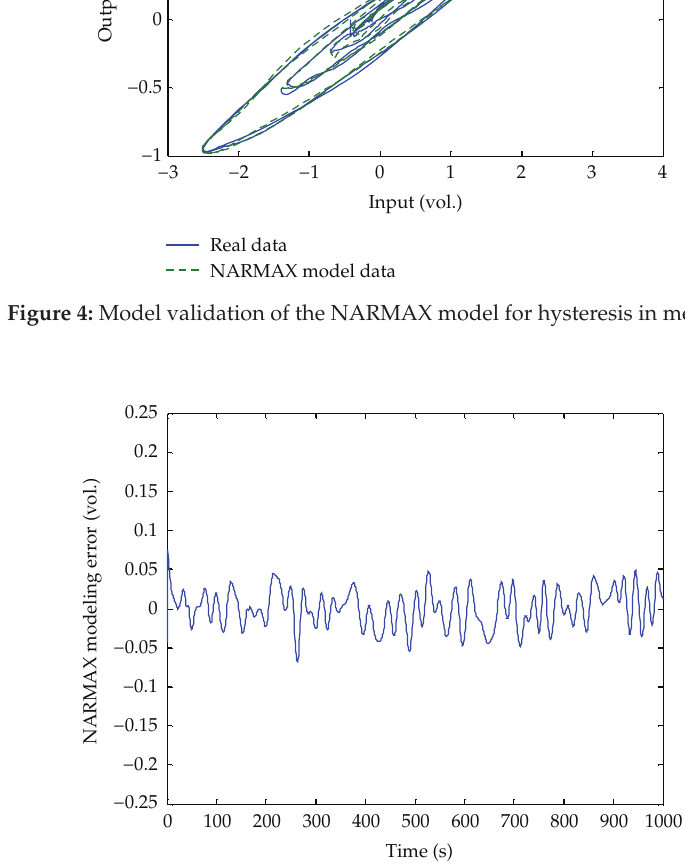
Figure 5: The modeling error of the NARMAX hysteretic